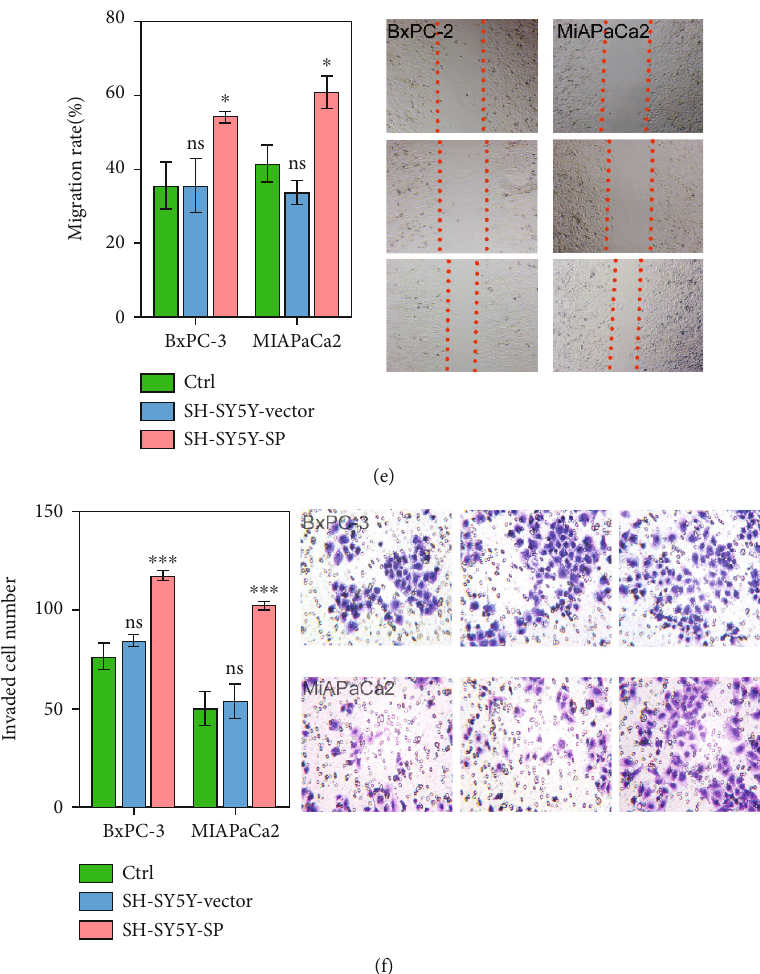
Figure 1: SP signi fi cantly promoted cell proliferation, migration, and invasion. (a) SP concentrations were measured using an ELISA kit. (b, c) Growth curves and proliferation rates for BxPC-3 and MIAPaCa-2 cells cultured with SP and SH-SY5Y were analyzed by CCK-8 and EdU staining assays. (d, f) Transwell assays were conducted to test the e ff ects of SP on cell migration and invasion. (e) Wound- healing assays were performed to evaluate the cell migration rates regulated by SP. ns: no signi fi cant di ff erence, ∗ P < 0 : 05 , ∗∗∗ P < 0 : 001 vs. SH-SY5Y-Vector